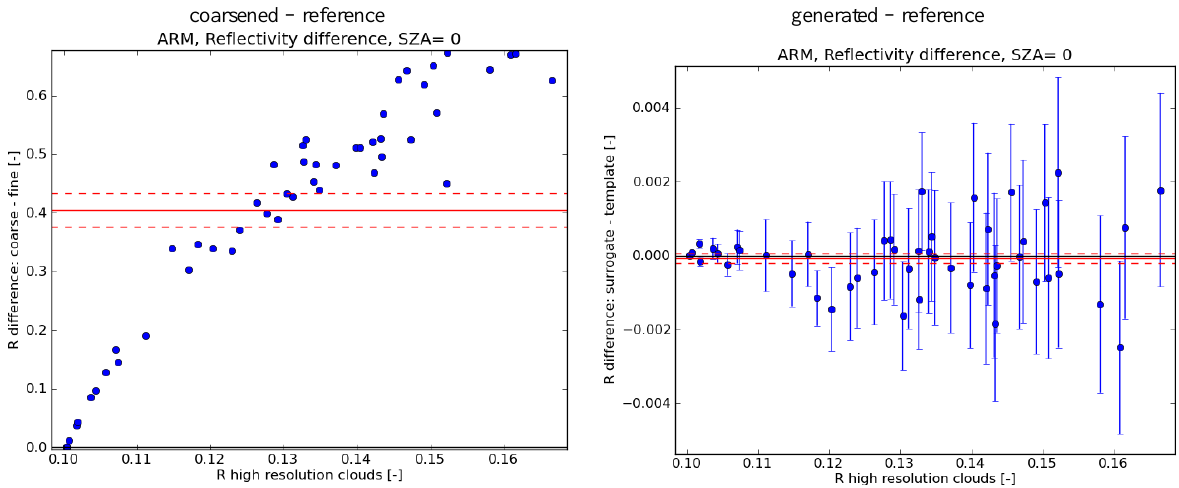
Fig. 6. Differences in domain-averaged reflectivity. The solar zenith angle was set to 0 ◦ . The abscissa indicates the mean reflectivity of the reference clouds and the ordinate indicates the relative differences. The blue dots represent the differences within a single cloudy scene and the error bars the corresponding standard deviations. The solid red line represents the mean bias of all cloud fields and the dashed red lines, the mean plus and minus the standard deviation, respectively.